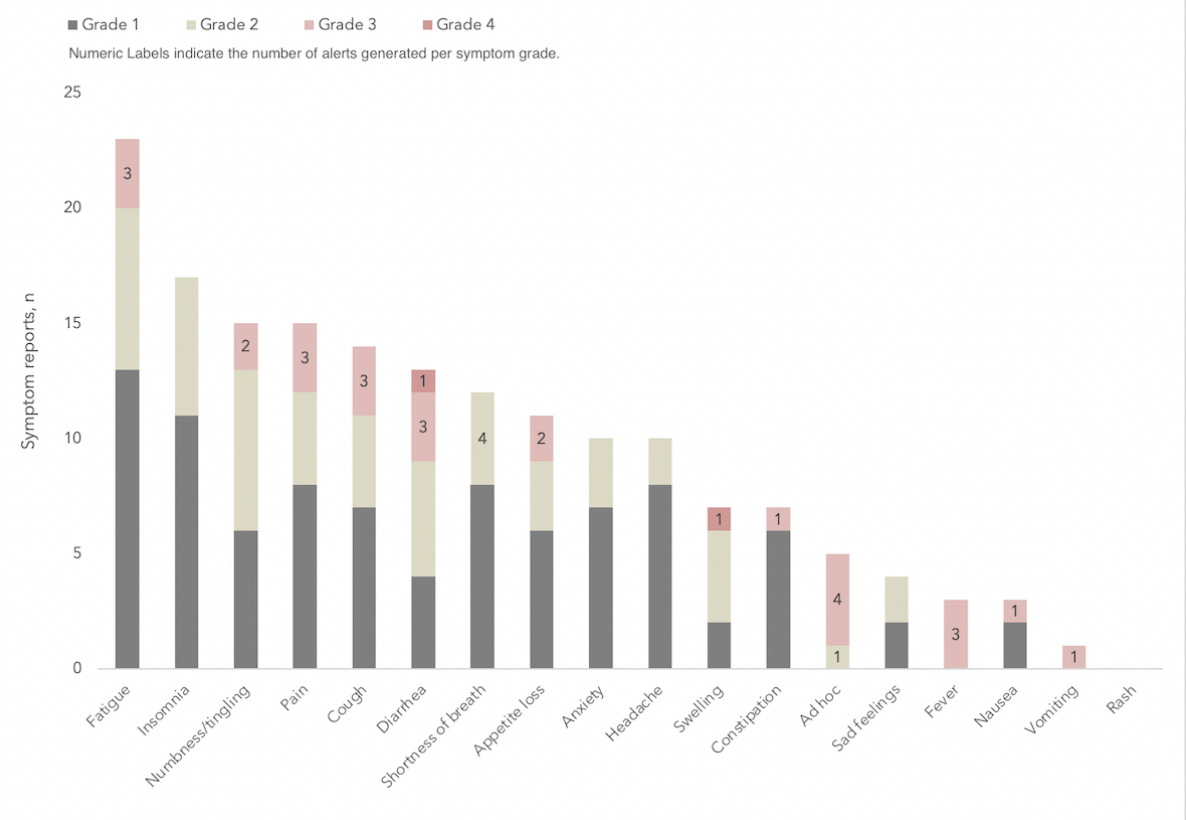
Figure 3. Frequency of reported symptoms and